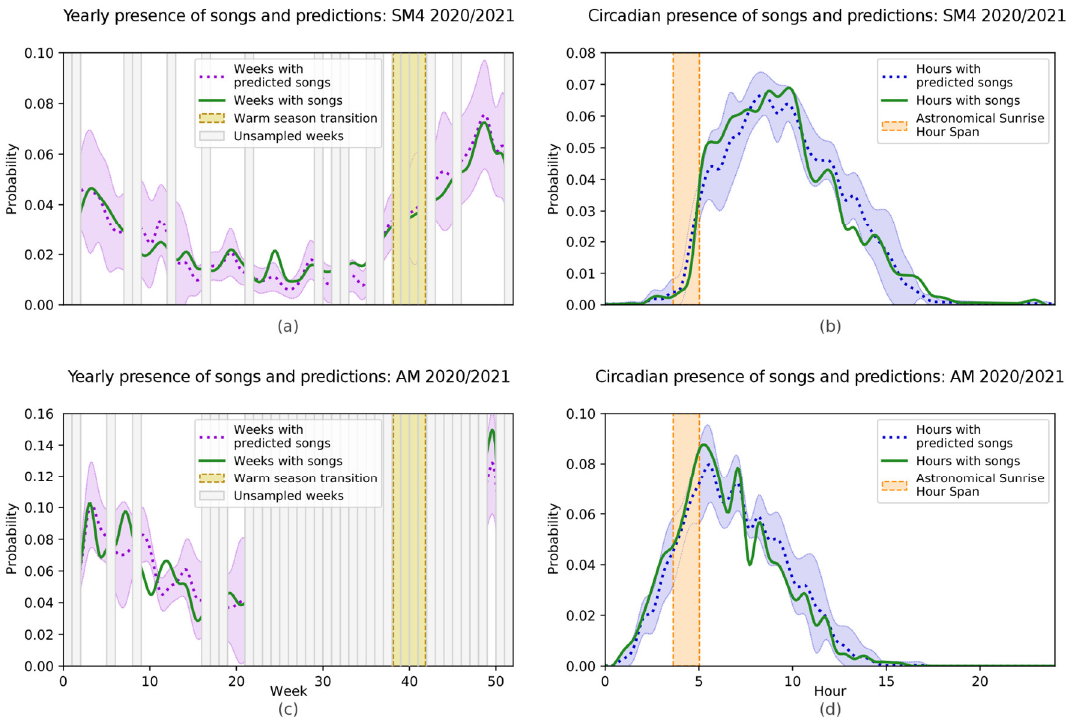
Figure 3. Yearly and circadian trends of the presence of songs and song predictions (positive cases of classification). ( a , b ) report data for the SM4 2020/2021 dataset; ( c , d ) report data for the AM 2020/2021 dataset. We considered a week unsampled if less than 250 recordings ( ≈ 40 h) were present; we did not use recordings of unsampled weeks to compute the probabilities for plots ( a , c ), related to yearly trends, while we employed all recordings for plots ( b , d ), related to circadian trends. In the plots representing the yearly trend, we highlighted the typical period that presents a transition between the cold and warm seasons, while for those concerning the circadian trends we highlighted the astronomical sunrise hour. Dotted lines and shaded areas represent, respectively, the mean and the area between three standard deviations obtained from the ten iterations of cross-validation. We report the trends regarding erroneous and missed predictions in Figure S2 and Figure S3,